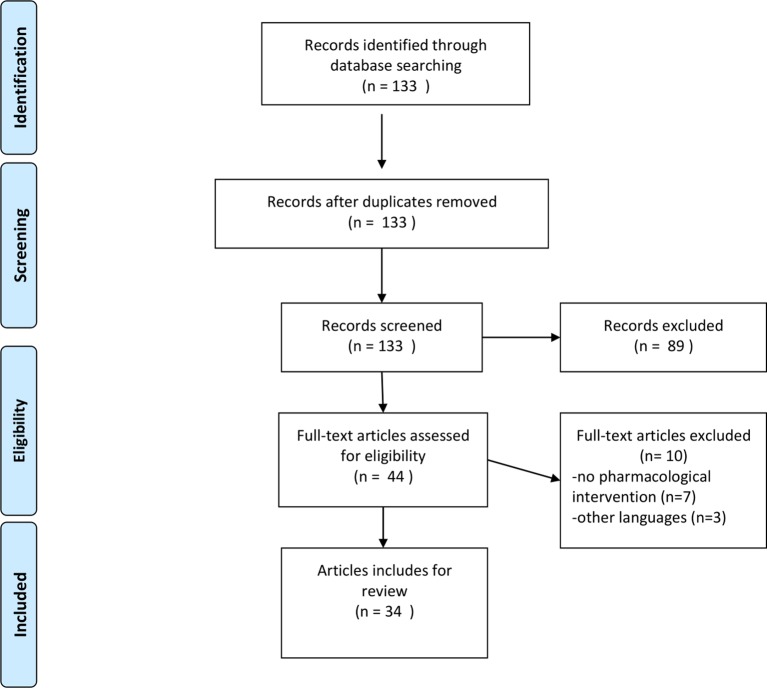
Study flow diagram.